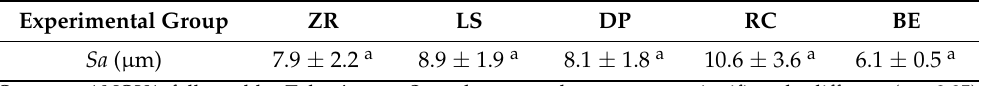
Table 3. Mean ± standard deviation of surface roughness ( Sa ) of the abrader specimens. Experimental